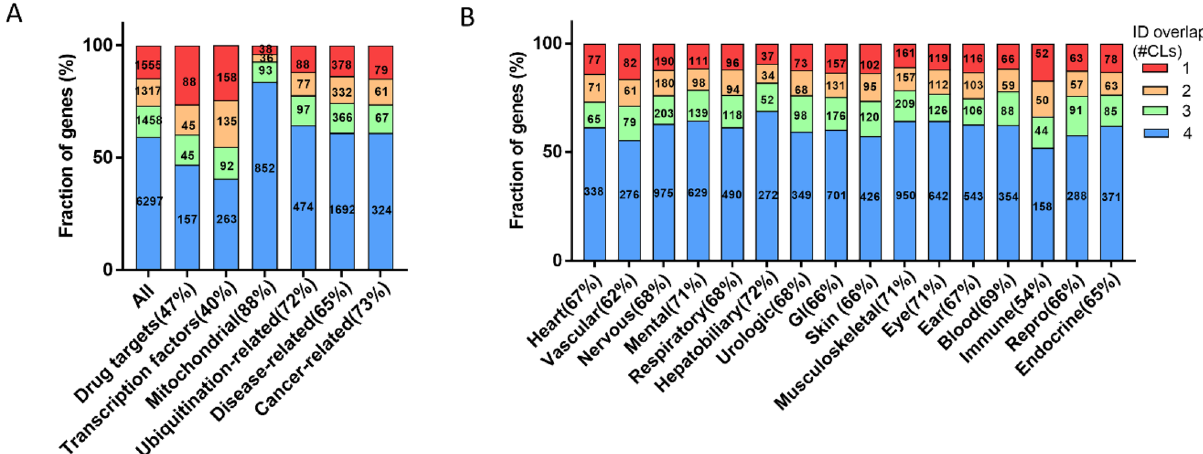
Figure 4. Relative distribution and absolute numbers of proteins in selected functional categories ( A ) and different organ classes ( B ). The coloring of the bars indicates fractions of proteins that are expressed in all or detected in certain number of cell